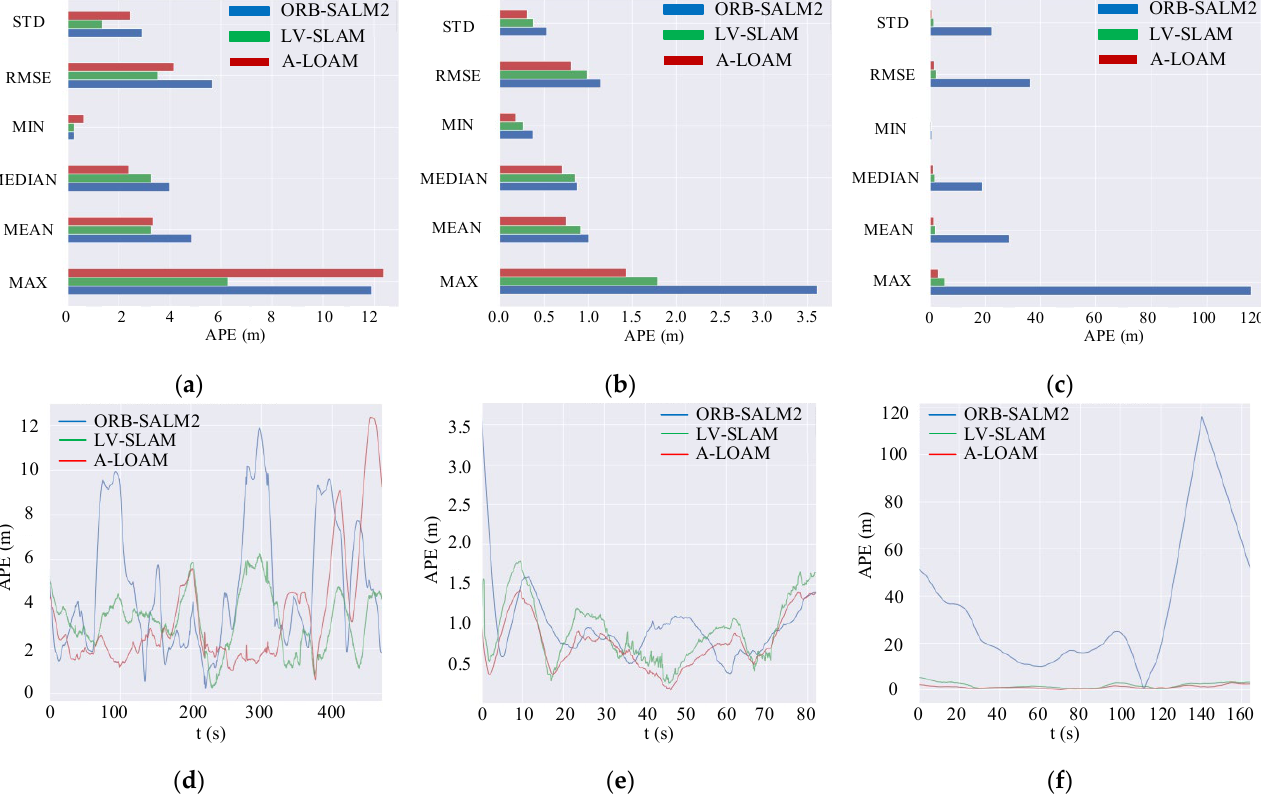
Figure 8. Comparison of trajectory errors of KITTI sequences. The datasets are chosen from three types of environments: urban, country, and suburban from left to right. In ( a – c ), we compare the kinds of error indicators of the fusion SLAM algorithm LV-SLAM to the visual SLAM algorithm and the lidar SLAM algorithm, including the maximum error (MAX), the mean error (MEAN), the median error (MEDIAN), the minimum error (MIN), the root-mean-square error (RMSE), and the standard deviation (STD). The corresponding absolute error of the motion trajectory is a function of travel time in ( d – f ).